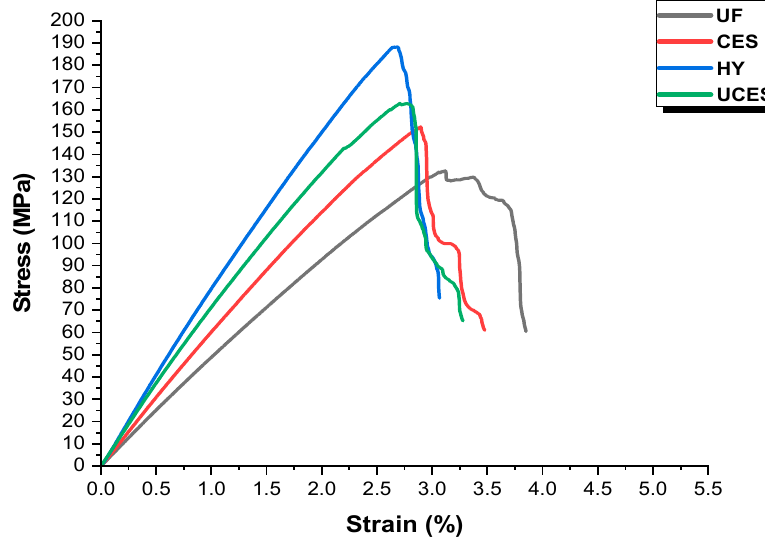
Figure 8. Flexural modulus comparison of composite variants.